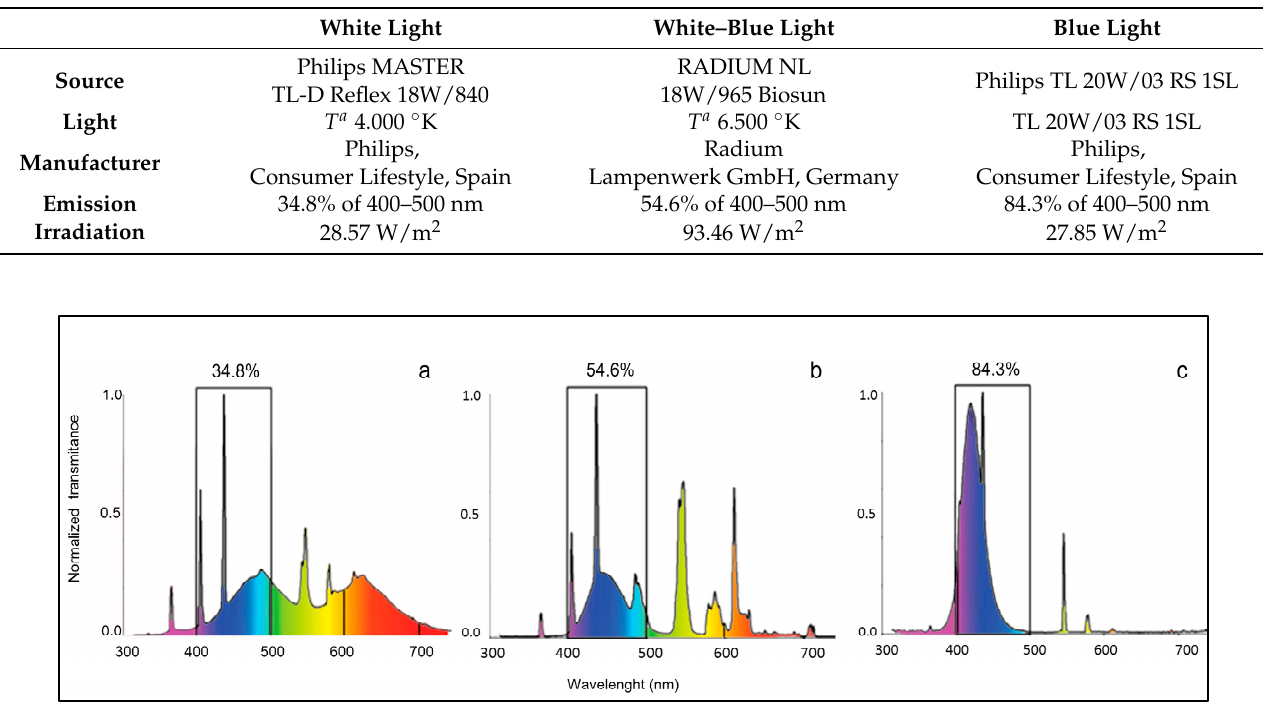
Figure 5. Spectral distribution of the illumination sources. ( a ) white light, ( b ) white–blue light, ( c ) blue light. The percentage of blue light emission for each experiment is indicated.